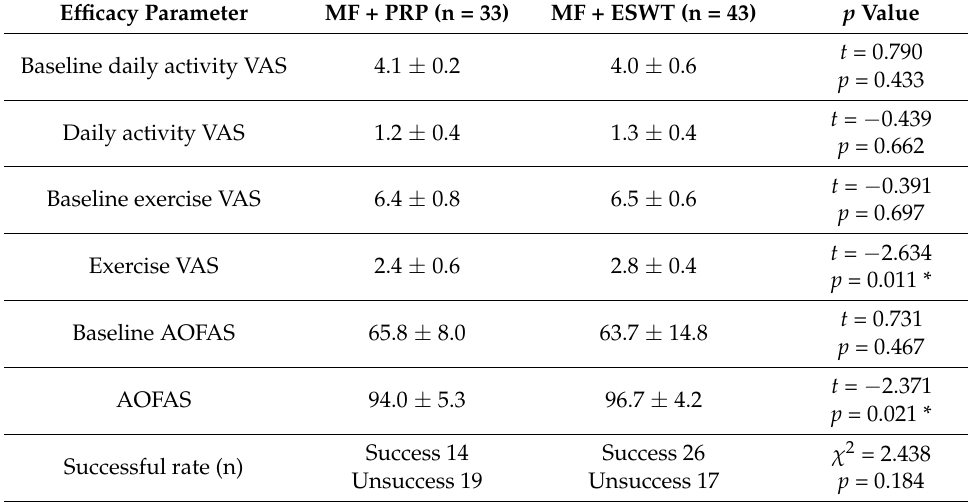
Table 2. Comparisons of the efficacy in the MF + PRP and MF + ESWT groups. Efficacy Parameter Baseline daily activity VAS